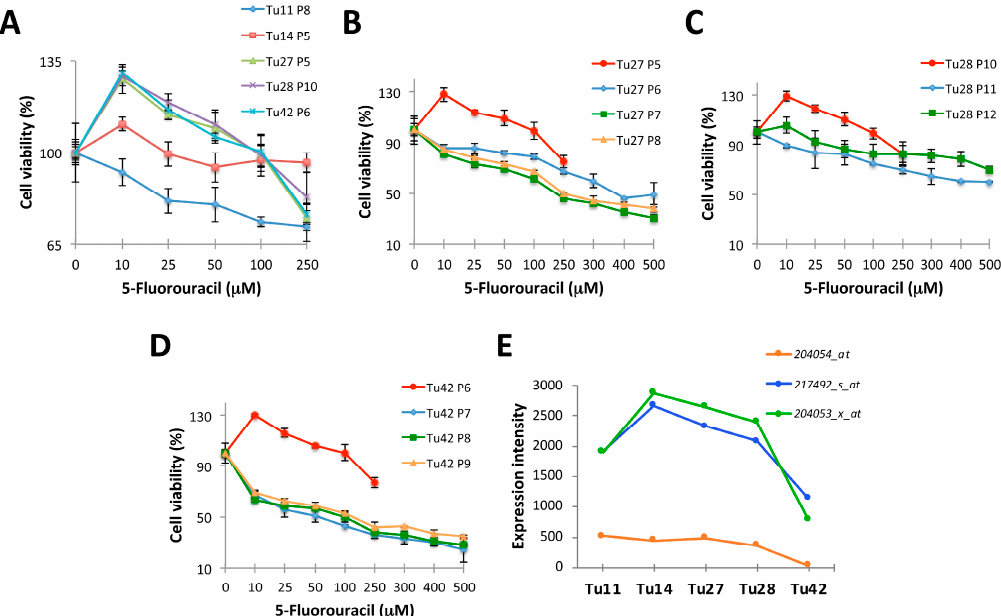
Figure 1. Establishment of 5-FU resistant human colorectal cancer (CRC) stem-like cells. ( A ) Line graphs showing cell viability (%) of Tu11, Tu14, Tu27, Tu28, and Tu42 CRC stem-like cells (P stands for passage) treated with vehicle or serial dilutions (10 – 250 µ M) of 5-FU. Data are expressed as mean percentage (± SD) of cell numbers relative to control culture. ( B–D ) Line graphs showing cell viability (%) of consecutive passages of Tu27, Tu28, and Tu42 CRC stem-like cells treated with vehicle or serial dilutions (10 – 500 µ M) of 5-FU. Data are expressed as mean percentage (± SD) of cell numbers relative to control culture. ( E ) Line graph showing the expression intensity of PTEN / MMAC1 / TEP1 in short-term feeder-expanded Tu11, Tu14, Tu27, Tu28, and Tu42 CRC stem cells obtained using three different microarray probes (204054_at; 217492_s_at; 204053_x_at).